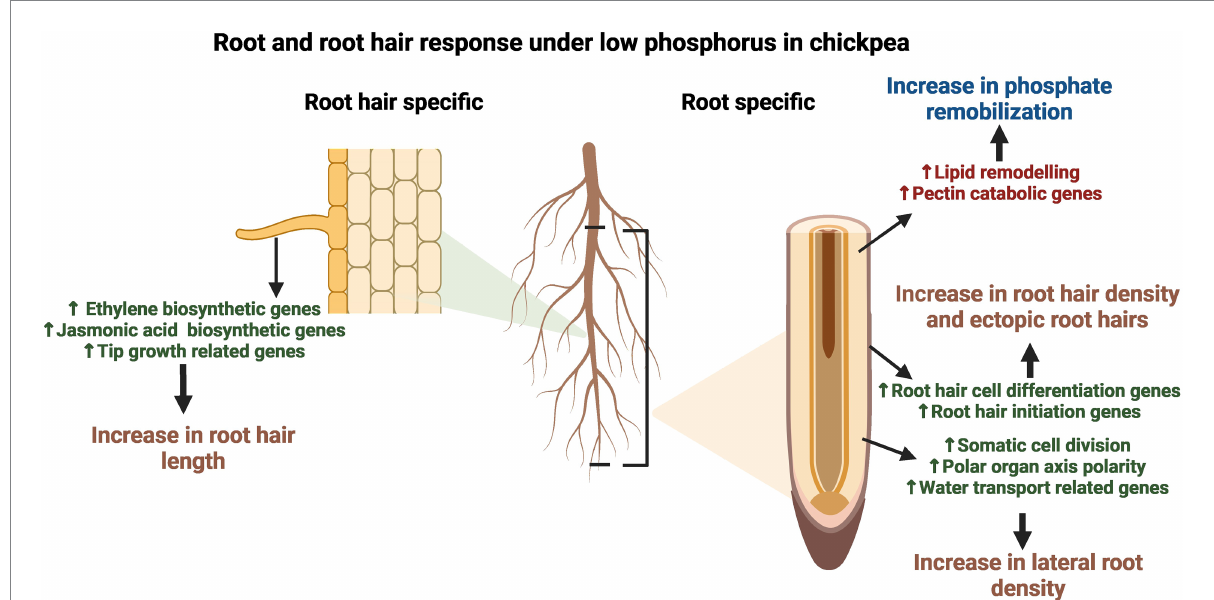
FIGURE 7 Summarized model of root and root hair (RH) response under low phosphorus (LP) in chickpea. The figure illustrates the tissue-specific upregulation of developmental and LP responses. The fully expanded RH depicts upregulation of ethylene and jasmonic acid biosynthetic genes, along with genes involved in tip growth processes like cell wall and lipid modulation and cytoskeleton/vesicle transport-related genes, which lead to an increase in root hair length under LP. In contrast, root without root hairs (Root-RH) depicted an increase in genes involved in RH cell differentiation and initiation, leading to an increase in root hair density and ectopic root hair formation. In addition, lateral root density increases in LP due to the upregulation of genes involved in processes like somatic cell division, polar organ axis polarity, and water transport. Further, both RH and root-RH showed upregulation of various LP tolerance genes; however, many pectin catabolism and lipid remodeling related genes are upregulated in root-RH for remobilization of phosphorus from the cell wall and lipids,